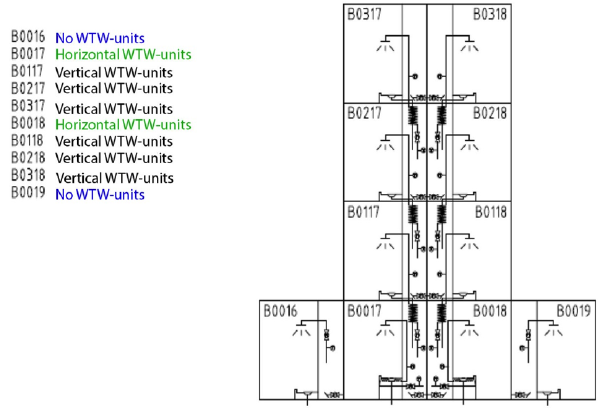
Figure 3. Experimental setup of the laboratory configuration.